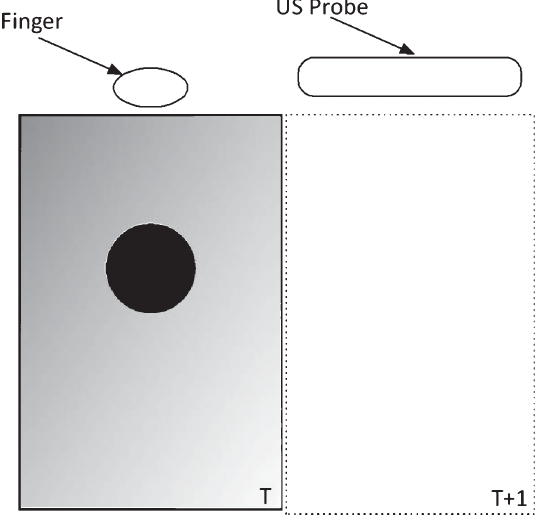
Fig. 3. Two different strategies for the exploration of the surface by theultrasoundprobehavebeenpresented.Thefirststrategyproposes that: At the time T the portion explored was calculated at the time T − 1, while the system calculates the portion that will be explored in T+1.